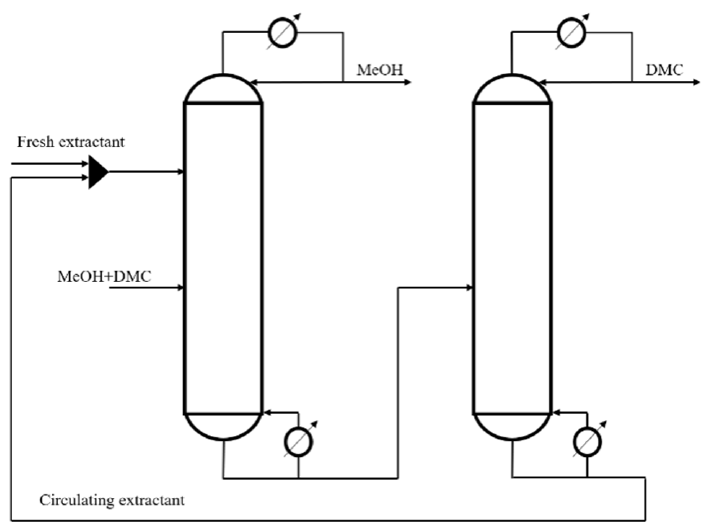
Figure 1. Conventional extractive process.